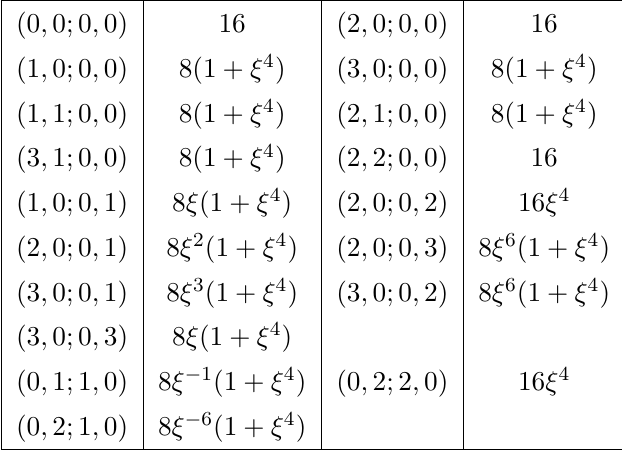
Table 4 . Multiplicities and phases of effective Z 4 × Z 4 twisted sectors in Z 8 × Z 8 orbifold with discrete torsion for some representative